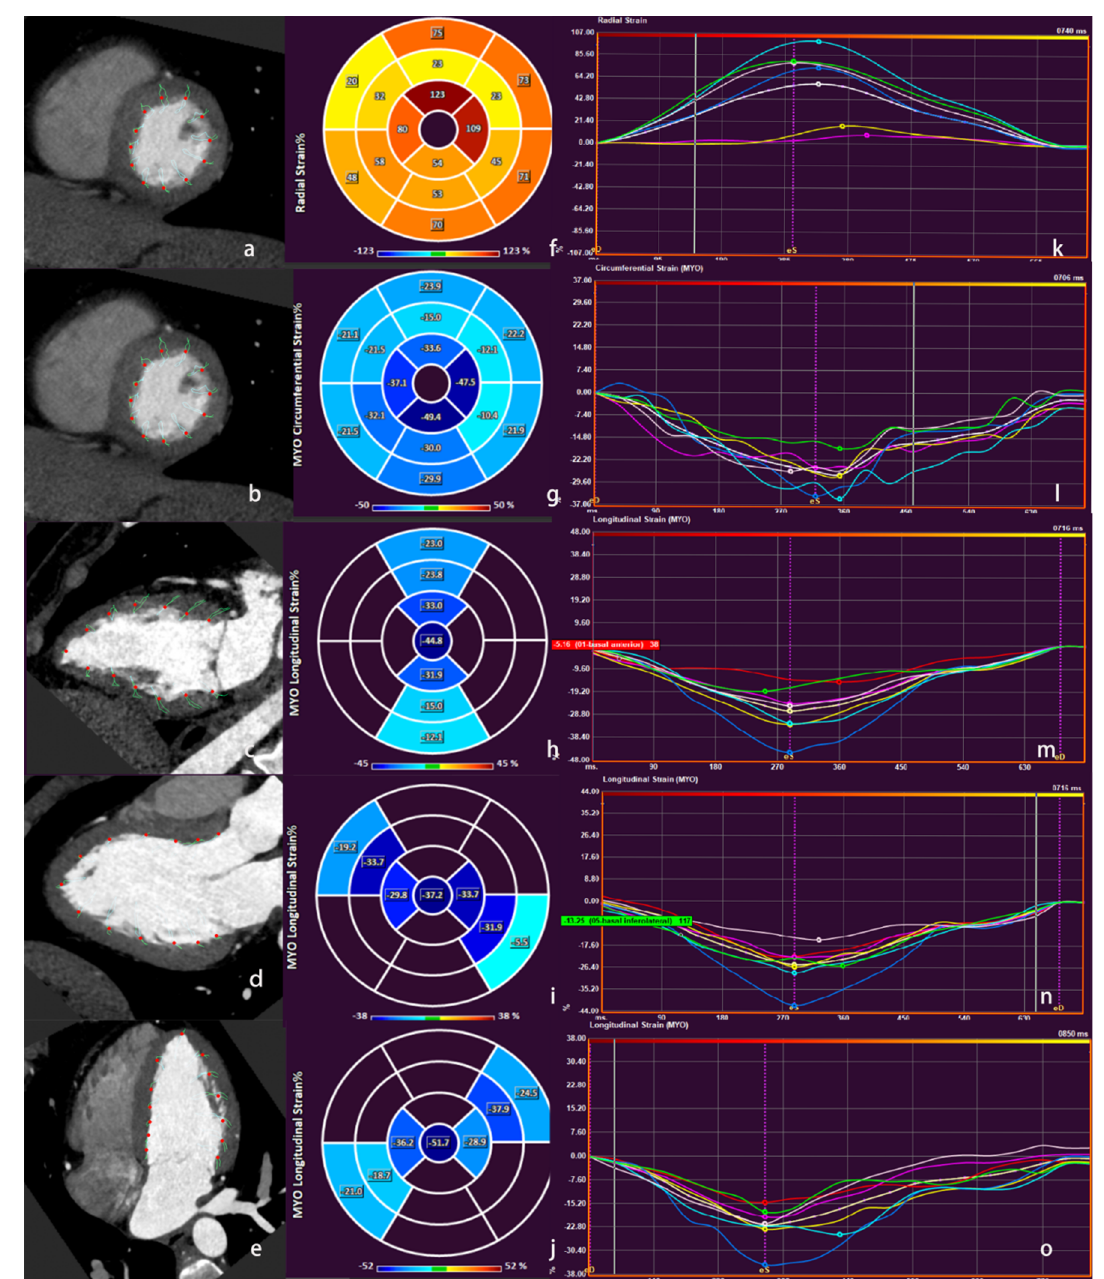
Figure 1. Schematic diagram of myocardial strain on post-processing software. ( a – e ) Images of different planes of the cardiac; ( f – j ) images of Err, Ecc and Ell on the short axis of the cardiac; ( k – o ) curves of myocardial strain and time in the cardiac cycle. Err: radial strain; Ecc: circumferential strain; Ell: longitudinal strain.